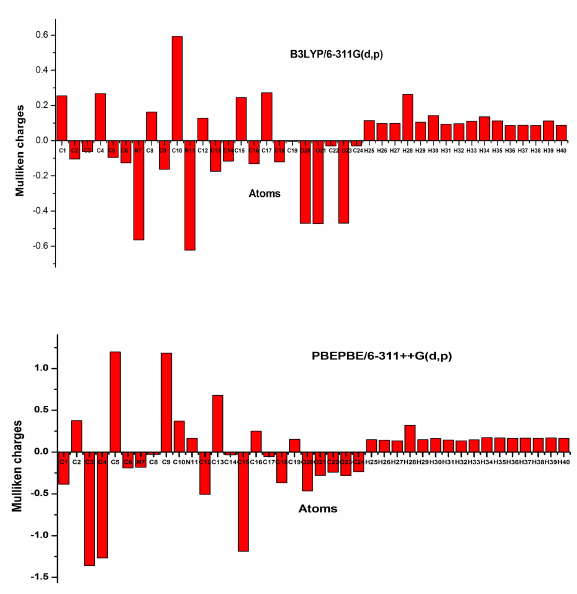
Figure 3 .Mulliken charge distribution of MIMIM calculated by B3LYP and PBEPBE